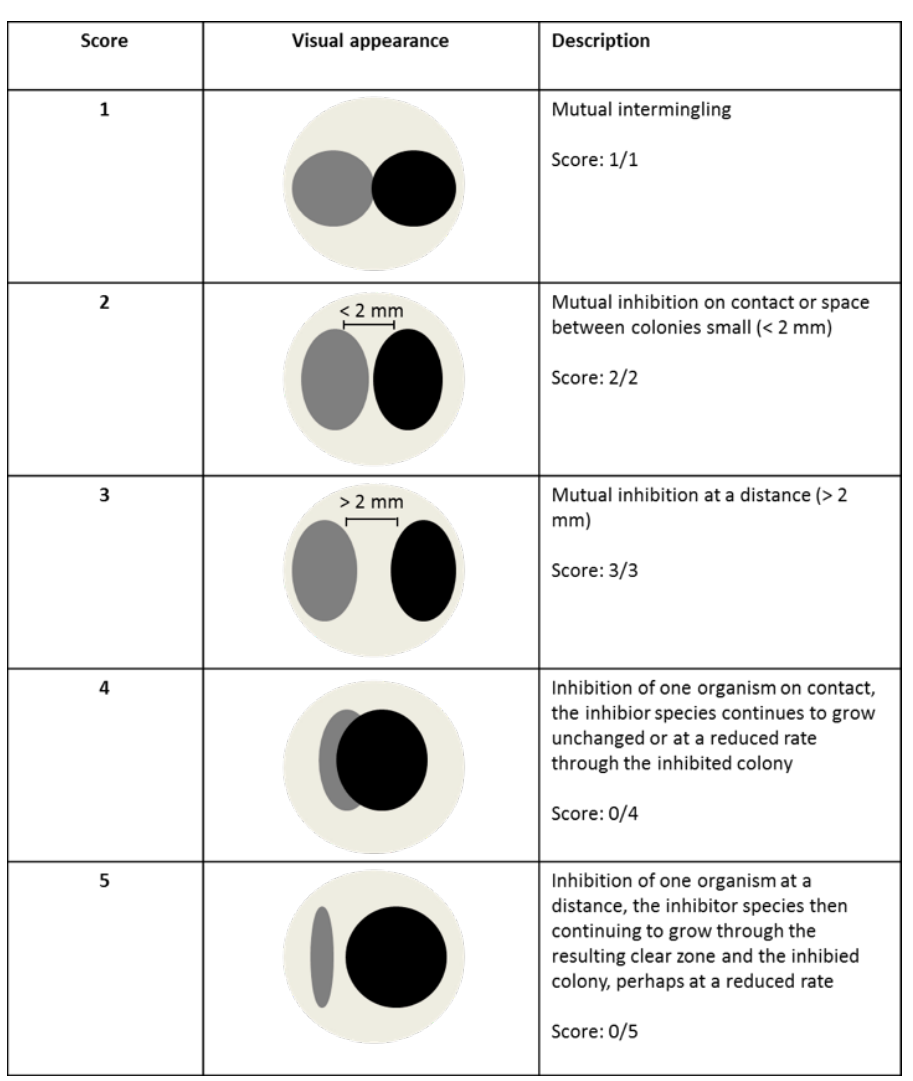
Table 3. Scores, visual appearance and description used to classify interactions between fungal colonies on agar media (Adapted from Magan and Lacey,